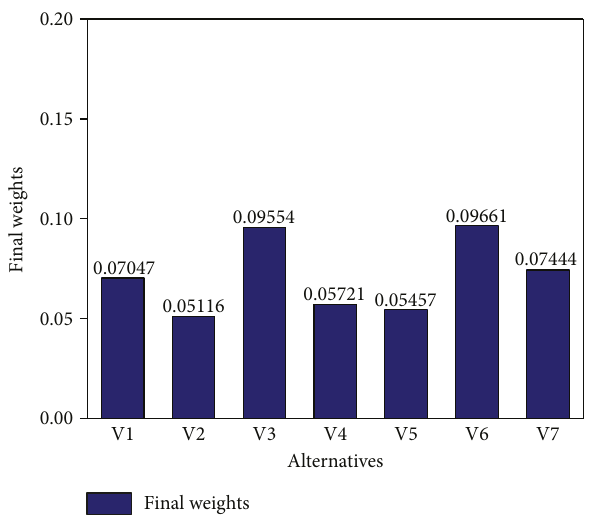
Figure 2: Final weights of elements in alternative